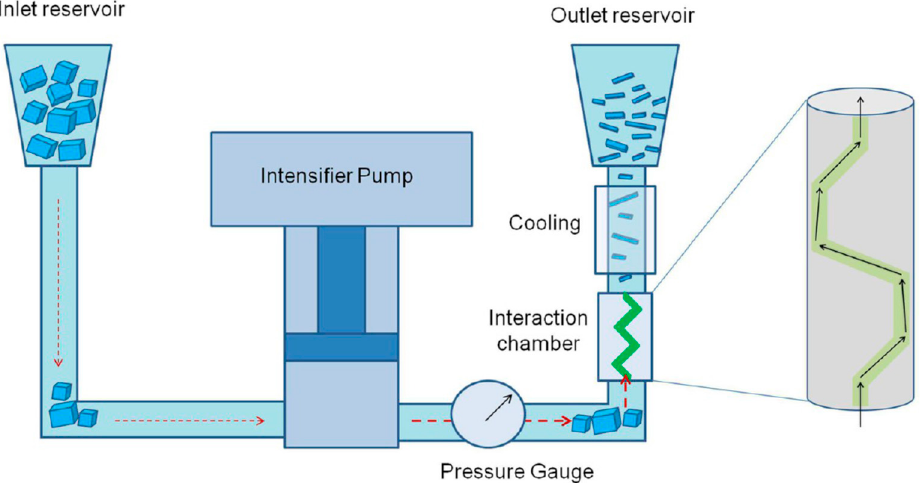
Figure 10. Schematic of the microfluidization process. An intensifier pump applies high pressure (up to ~207 MPa) and forces the suspension to pass through the microchannel of the interaction chamber where intense γ 10 8 s − 1 is generated. The processed material is cooled and collected from the outlet reservoir. The process can be repeated several times. Reproduced from [23]. Copyright American Chemical Society, 2017.